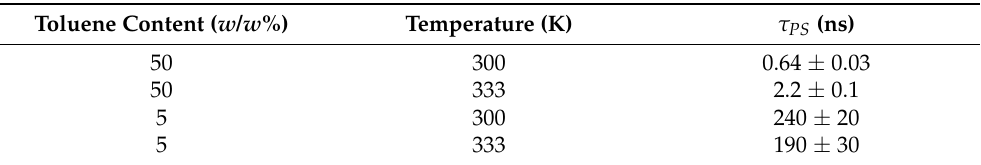
Figure 5. Autocorrelation functions of the end-to-end distance for the systems of 50 w/w% toluene at 300 K and 333 K ( a , b ) and 5 w/w% toluene at 300 K and 333 K ( c , d ). Table 3. Relaxation time ( τ PS ) computed for systems at 50 and 5 w / w % toluene. Standard errors were calculated by dividing the 150 aPS chains into 10